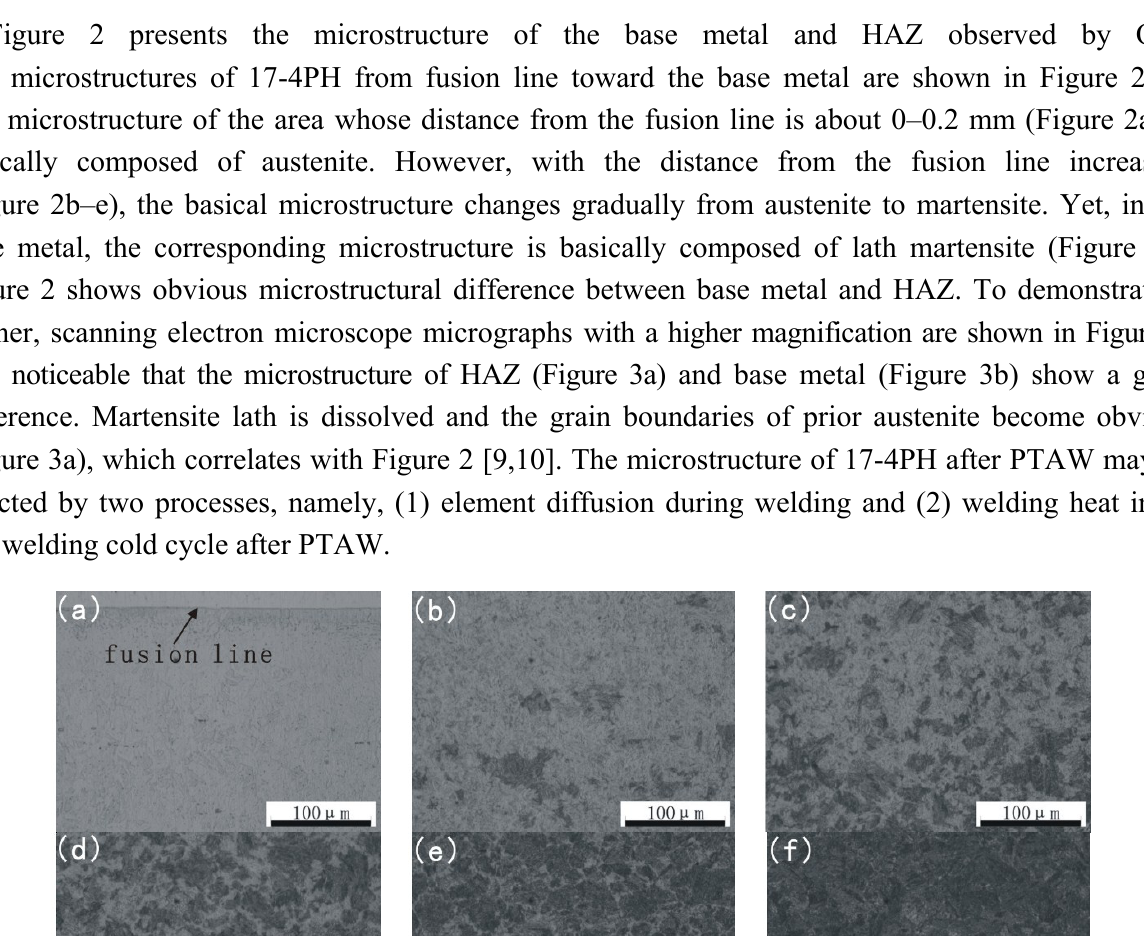
Figure 1. Variations of microhardness from base metal to heat affected zone (HAZ). (Hardness tester with a test load of 0.5 Kg).